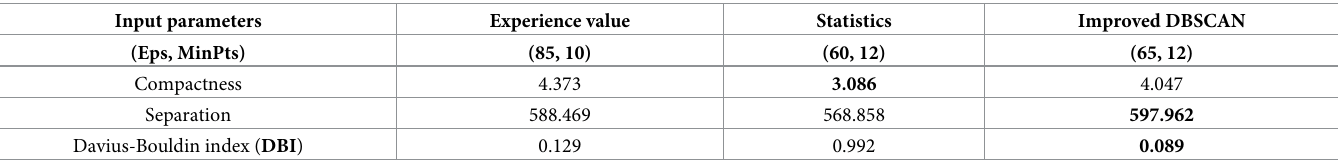
Table 5. Experimental results of different performance parameters.